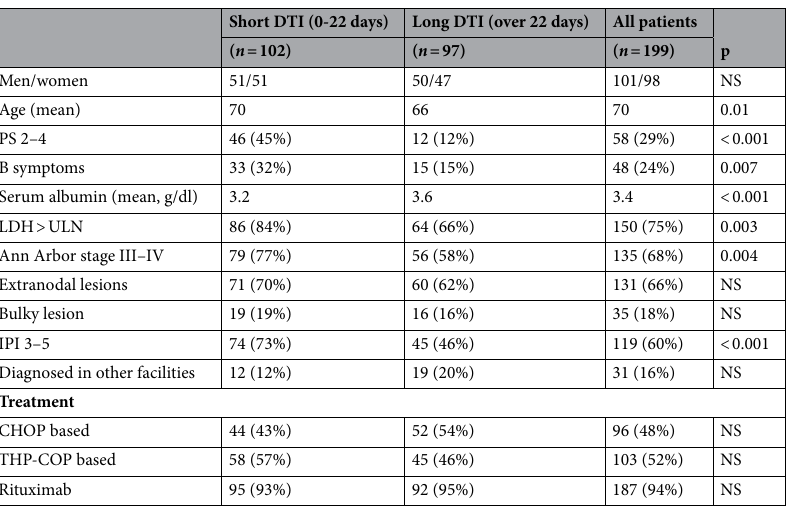
Table 1. Patient clinical and laboratory characteristics. PS performance status, LDH lactate dehydrogenase, ULN upper limit of normal, IPI International Prognostic